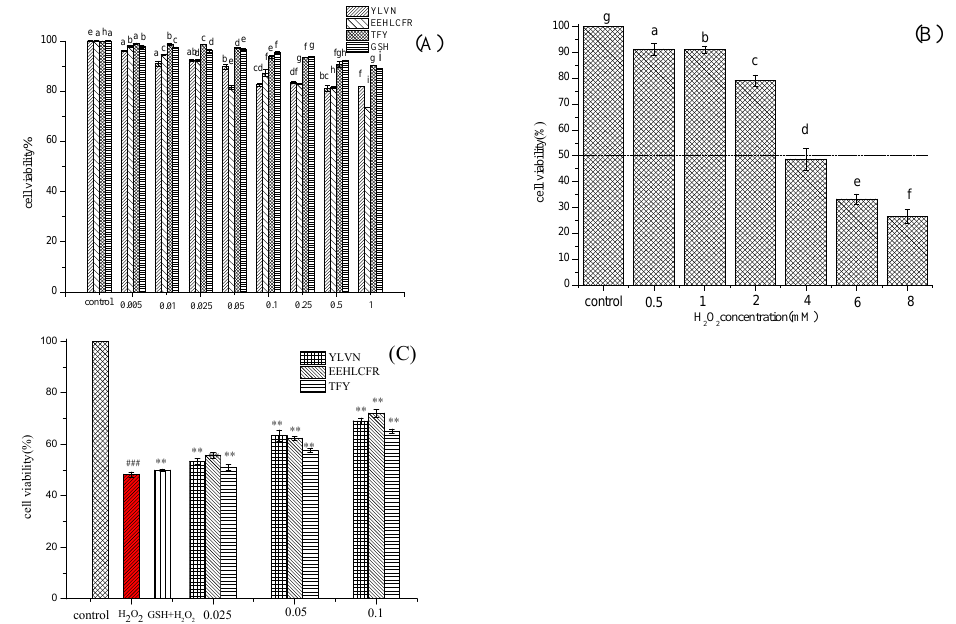
Figure 7. Effects of three peptides in H 2 O 2 -injured LO2 cells oxidative stress: Cell viability ( A ) Establishment of hydrogen peroxide concentration ( B ), Pre-protective effect of peptides ( C ). Different letters indicate significant differences ( p < 0.05). ### p < 0.001 versus the blank control group; ** p < 0.01 versus the H 2 O 2 -induced group; * p < 0.05 versus the H 2 O 2 -induced group, the same as below.